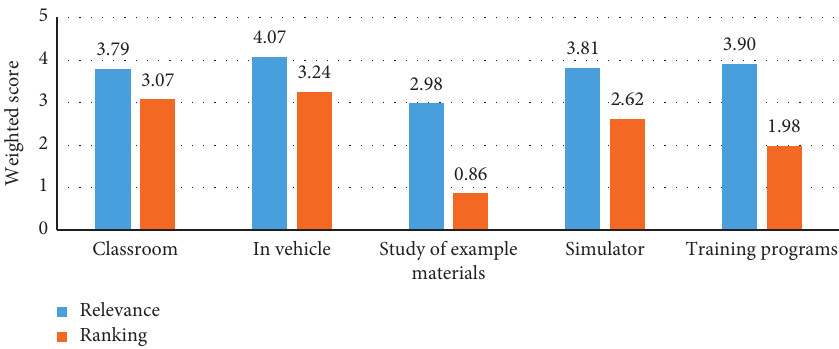
Figure 3: Weighted mean of relevance and priority ranking related to Question A2.